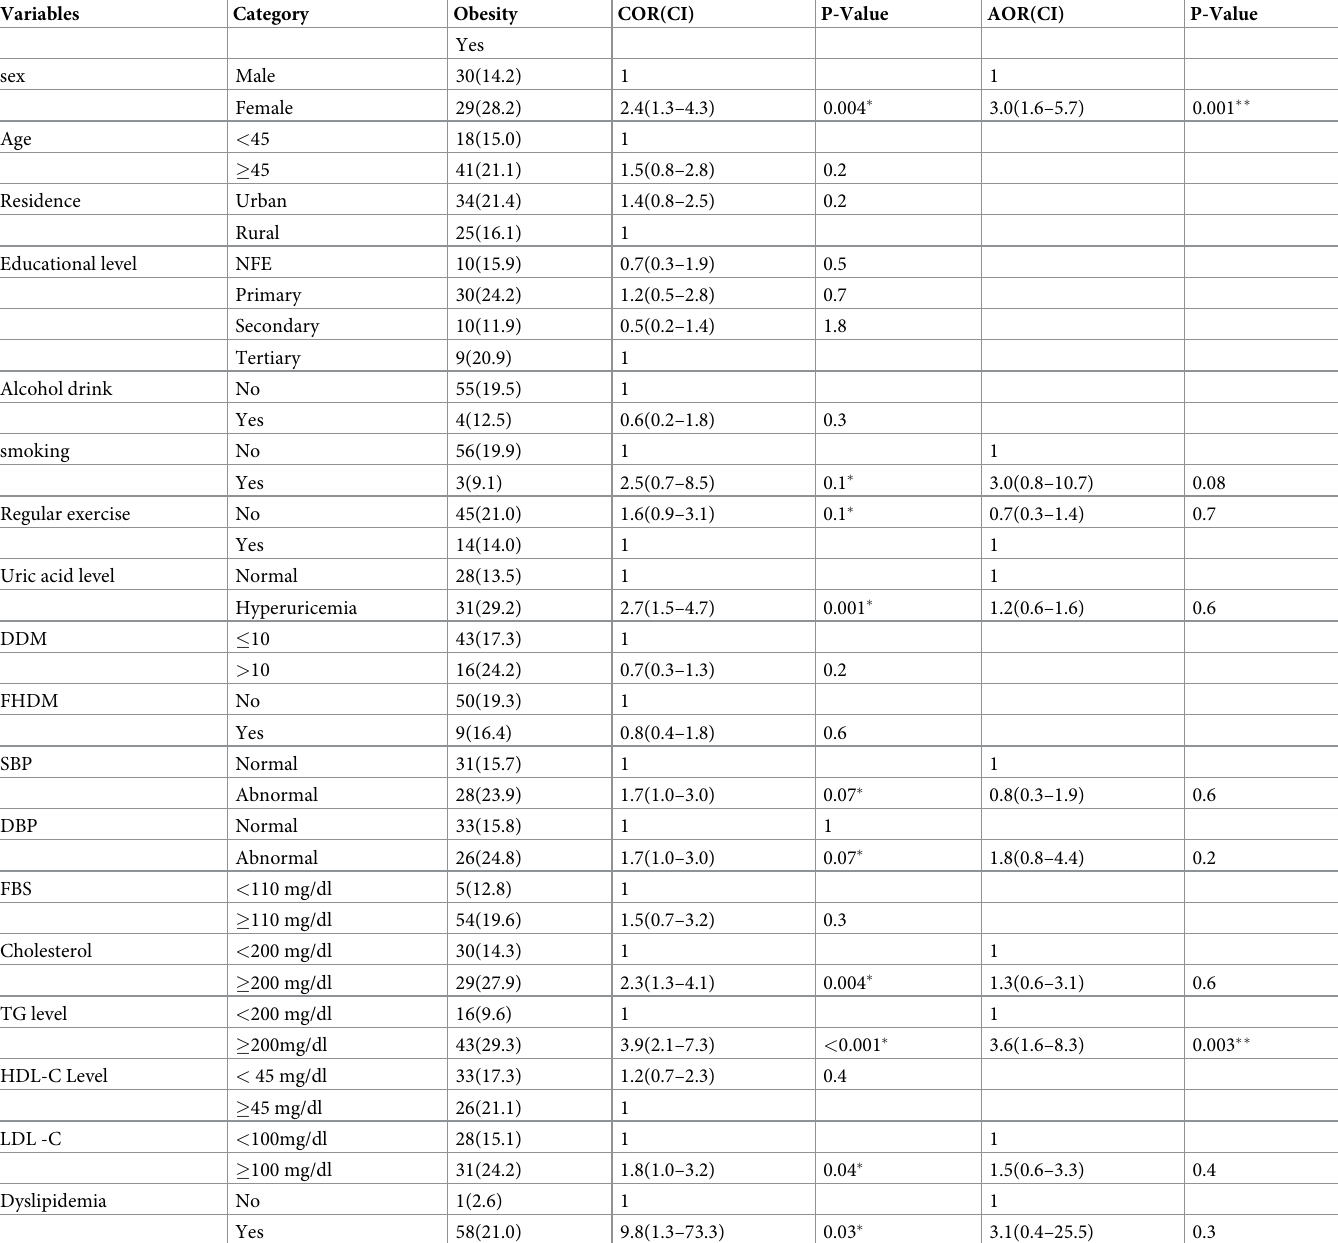
Table 3. Factors associated with obesity among T2DM patients at HUCSH and YGH from Oct 16 to Dec. 21, 2018.